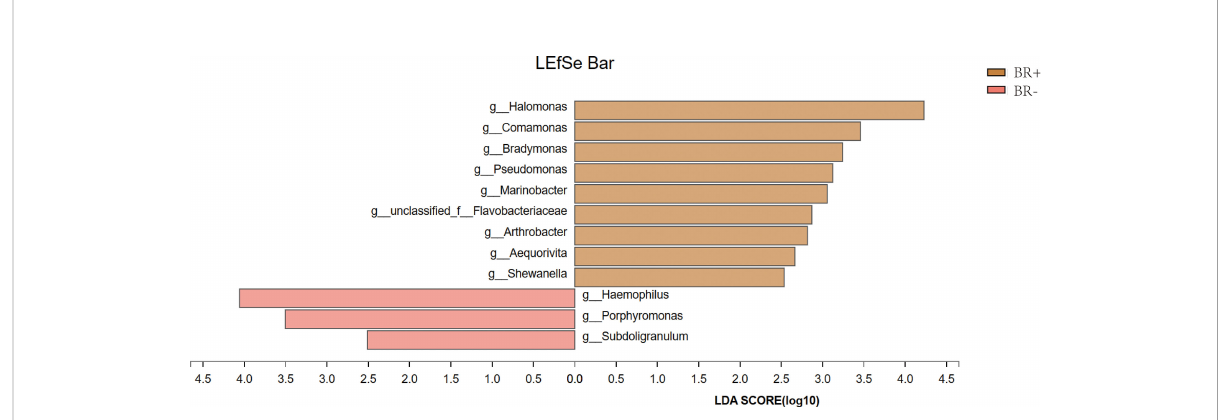
FIGURE 7 The most differentially abundant taxa between the BR+ and BR- groups using LEfSe